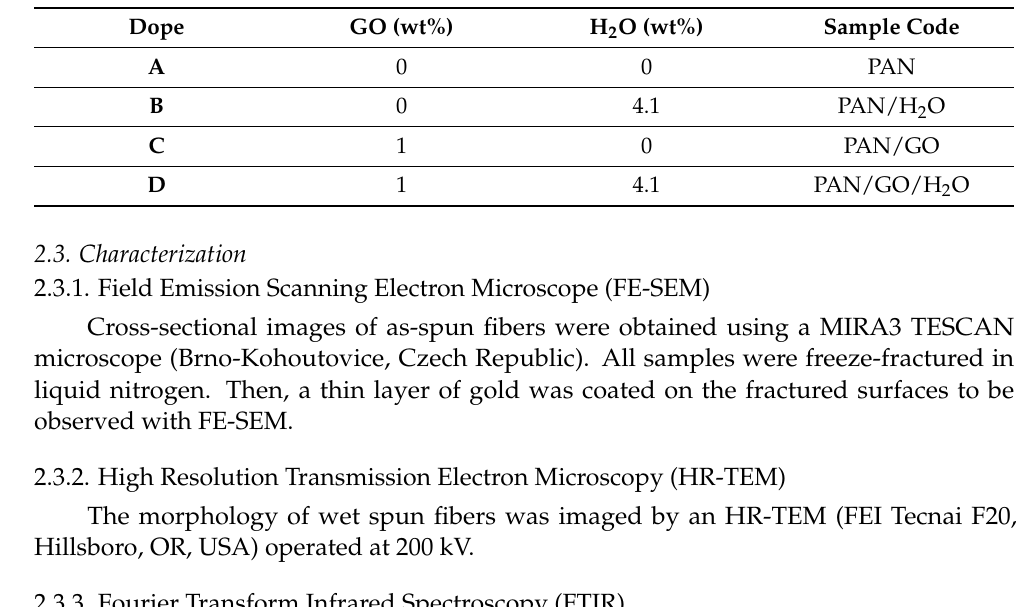
Table 1. Description of PAN-based